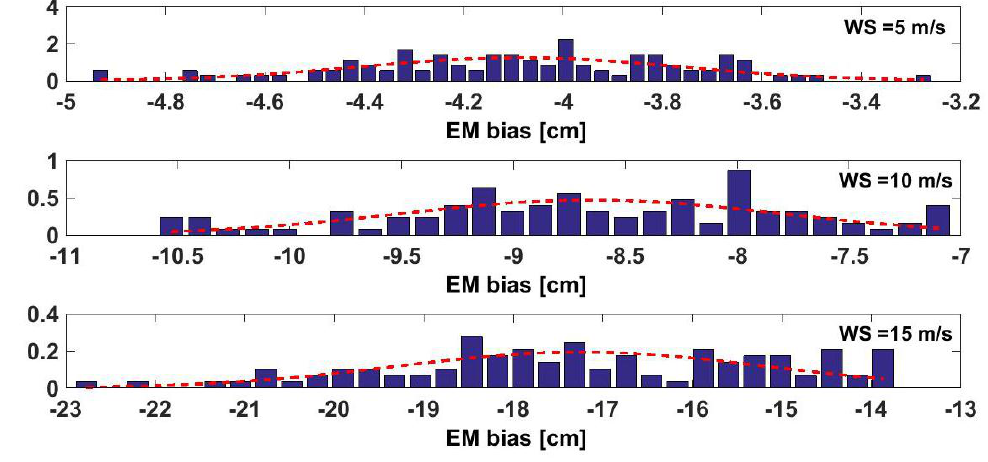
= θ = 25°, wind direction φ = 45°, and ( a ) U i s R R R R = 15 m/s. 10 R R